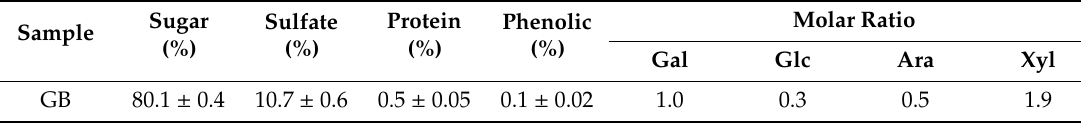
Table 1. Chemical composition of sulfated polysaccharides from G. birdiae (which we refer to as GB). Molar Ratio Sugar Protein Sulfate Phenolic Sample (%) (%) (%) (%) Gal Glc Ara Xyl GB 80.1 ± 0.4 10.7 ±